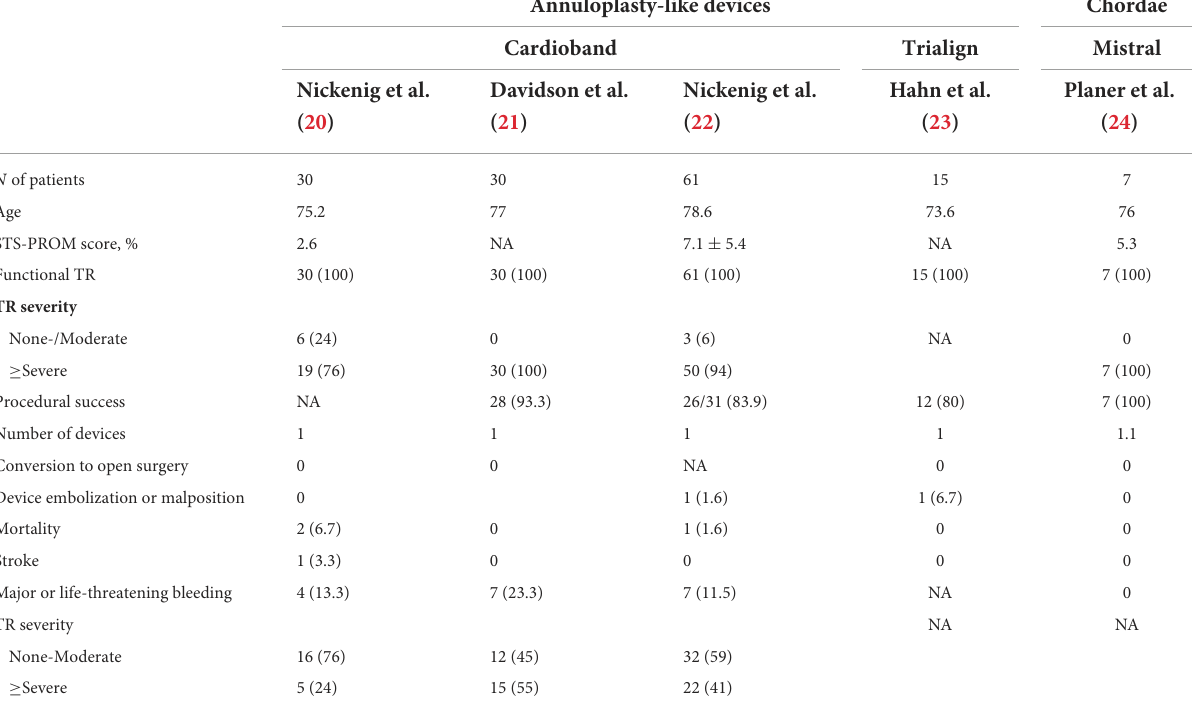
TABLE 3 Baseline and procedural characteristics and 30-day outcomes of patients undergoing TTV repair with annuloplasty-like devices. Annuloplasty-like